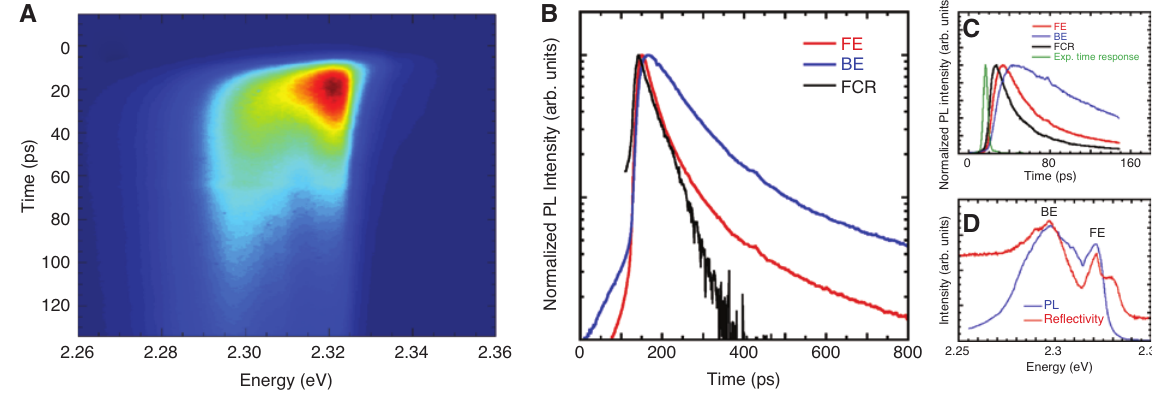
Figure 2: Bulk sample. (A) Photoluminescence (PL) time evolution after picosecond excitation at 3.35 eV. (B) PL decay at free carrier recombination (FCR), free exciton (FE) and bound exciton (BE) energies (log scale). (C) Rise of the PL for the FCR, FE and BE energies (linear scale). In green, the experimental time response is reported. (D) Time-integrated PL spectrum (blue) compared with the reflectivity spectrum (red). All the measurements reported in the figures were performed at 10